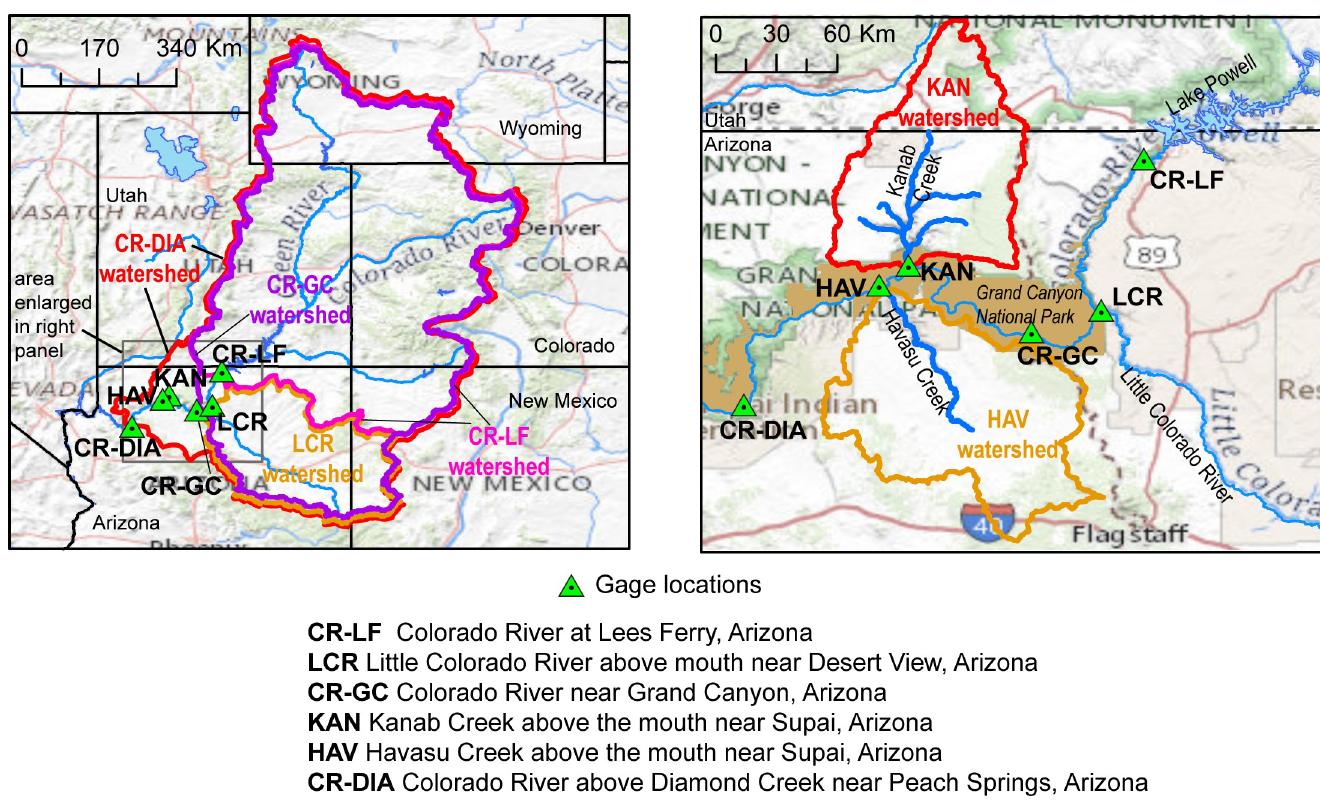
Fig 2. Watershed boundaries of three main-stem Colorado River monitoring sites (left panel) and three tributary monitoring sites (left and right panels) discussed in this study. Note that watersheds for all three main-stem Colorado River sites include the upper Colorado River basin and therefore overlap in the left panel. Map data from the USGS including the USGS National